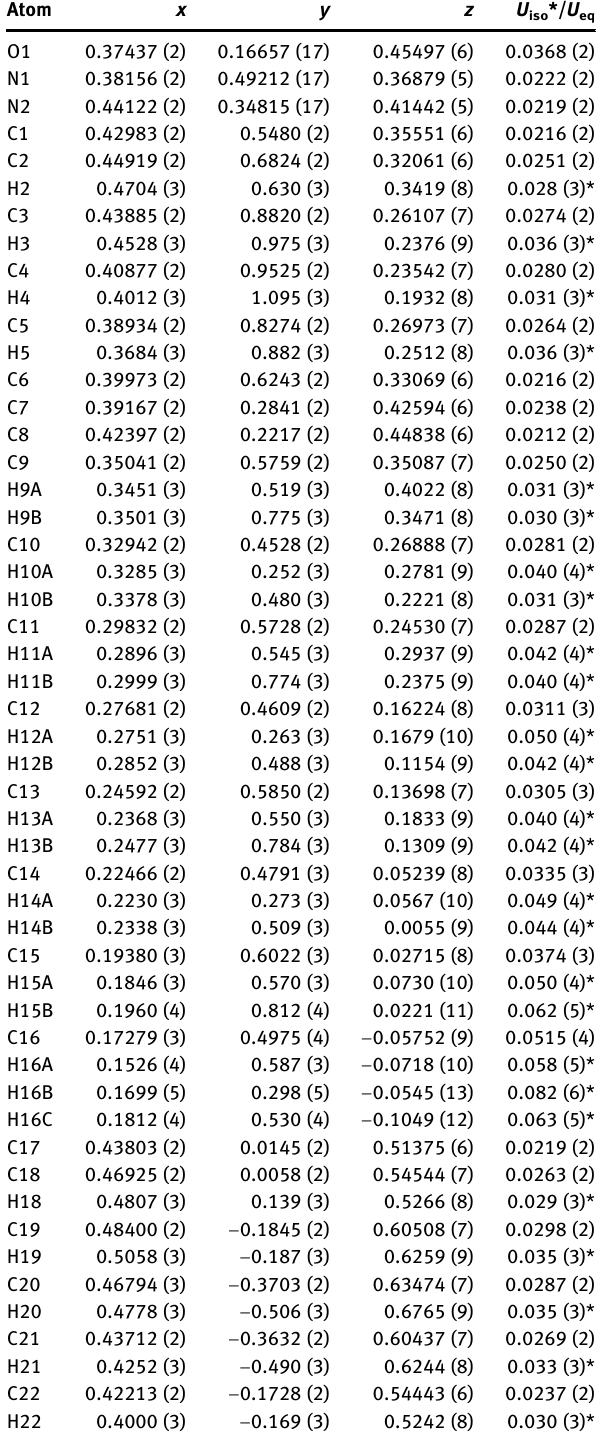
Table  : Fractional atomic coordinates and isotropic or equivalent isotropic displacement parameters (Å 